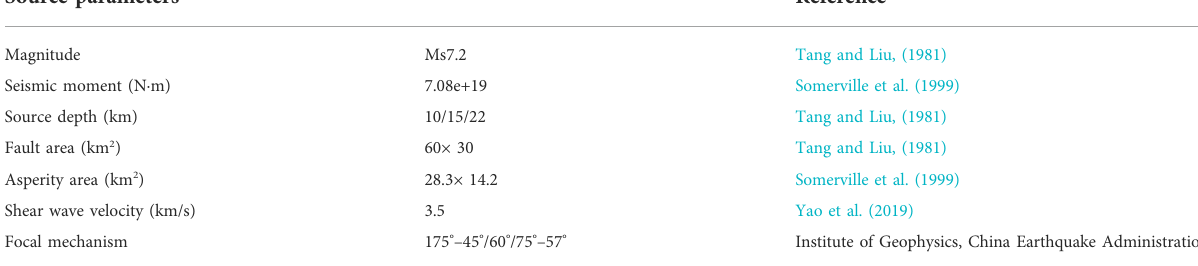
TABLE 2 Source parameters used in the empirical Green function method for Pingwu scenario